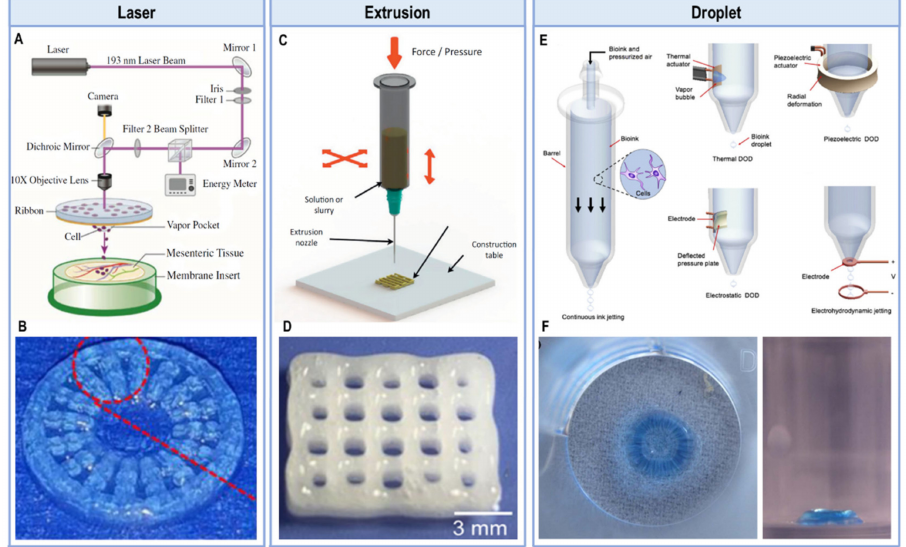
Figure 1. 3D bioprinting technologies and printed constructs (adapted with permission from